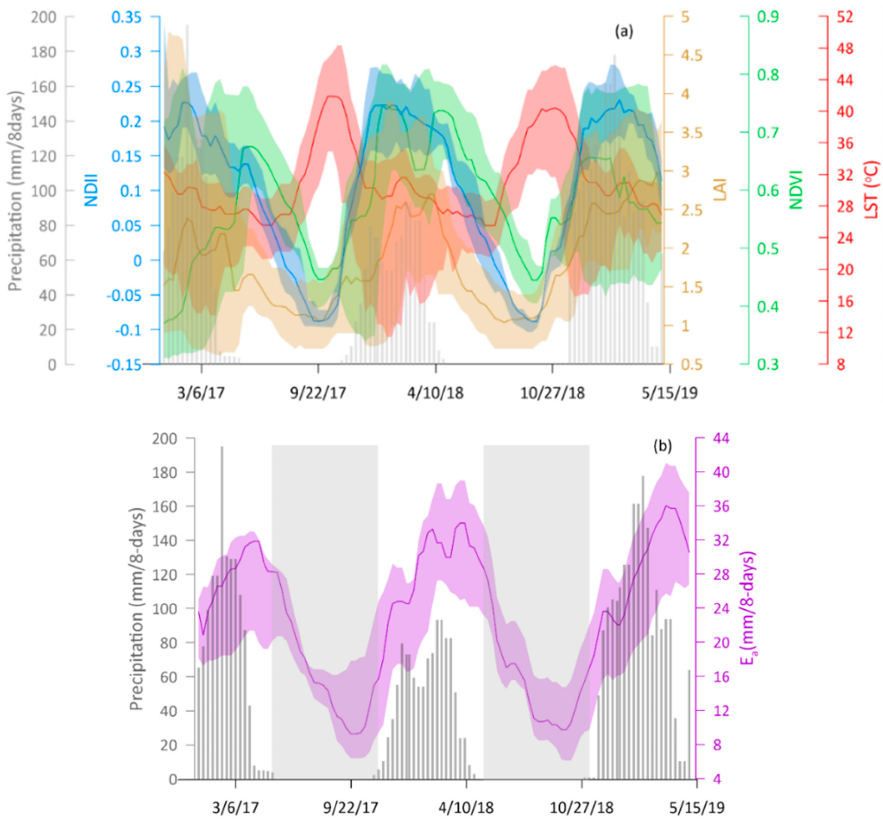
Figure 3. Illustration of ( a ) seasonal pattern in 8-day mean values of canopy cover (i.e., LAI and NDVI), canopy water content (i.e., NDII), and canopy temperature (i.e., LST). ( b ) Seasonal pattern in 8-day mean values of actual evaporation (E a ). Shaded area for variables is the 5th and 95th percentiles. The shaded area (grey) is the dry season. The rainy and dry season seasons are clearly delineated with peak values in Ea, LAI, NDII, and NDVI observed during the rainy season while lowest values were observed in the dry season. Peak canopy temperature (i.e., LST) value(s) were observed during the dry season. E a = Actual evaporation, LAI = Leaf area index, LST = Land surface temperature, NDII = Normalised di ff erence infrared index and NDVI = Normalised di ff erence vegetation